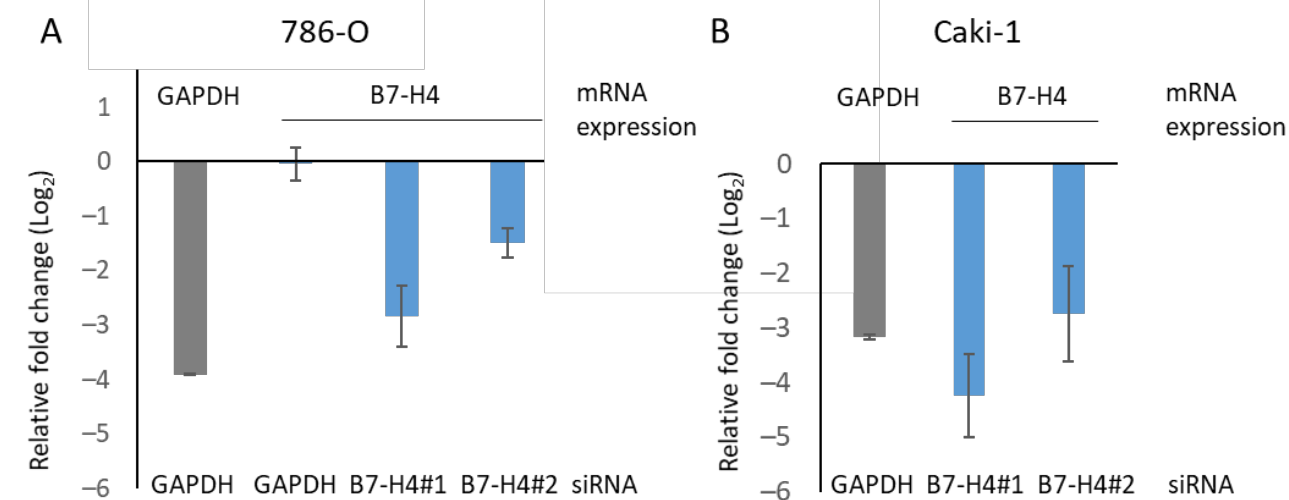
Figure 4. B7-H4 silencing analysis by RT-qPCR in renal cancer cells. Relative fold change in mRNA expression of GAPDH and B7-H4 by RT-qPCR of 786-O ( A ) and Caki-1 ( B ) cells. siRNA used are indicated in the bottom: GAPDH (siGAPDH transfected cells, positive control), B7-H4 #1 and B7-H4 #2 (siB7-H4 #1 and #2 transfected cells).